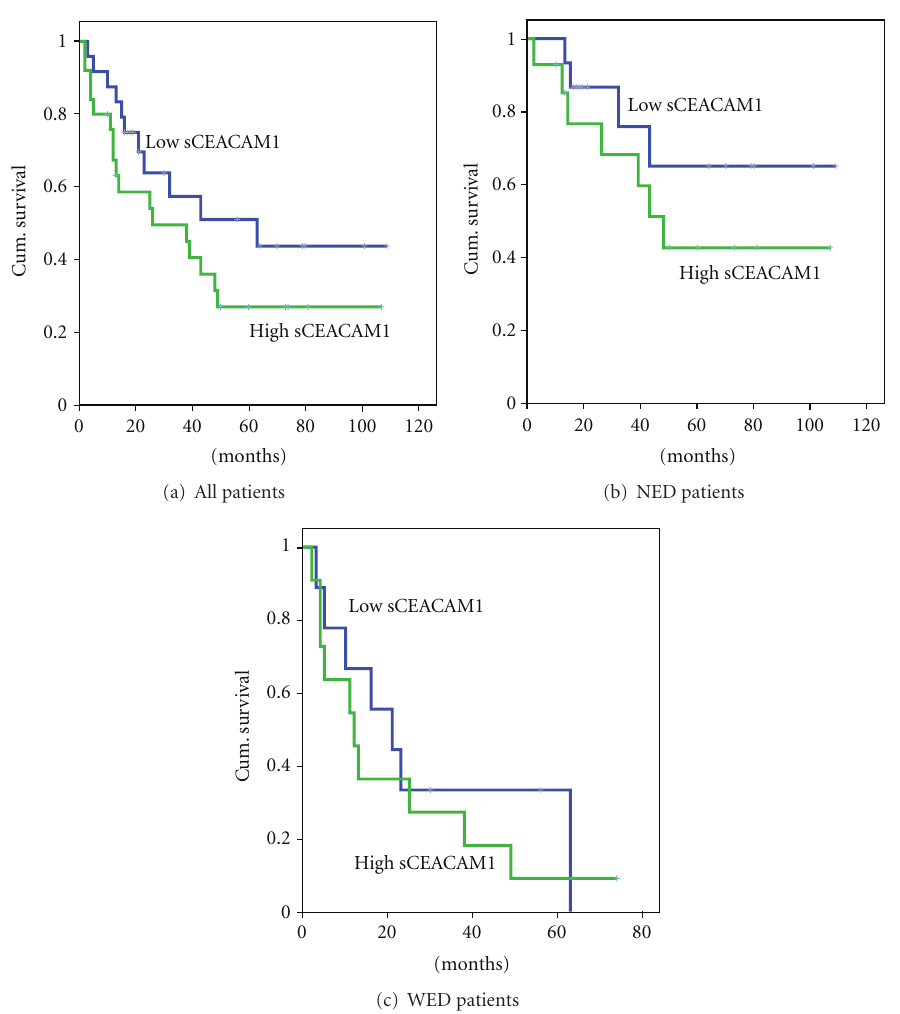
Figure 2: The correlations between sCEACAM1 and survival. The whole group of patients and NED exclusively or WED exclusively were divided into two groups (“low”/“high”) according to pre-treatment sCEACAM1 median level, and the survival rate of each subgroup was analyzed by Kaplan-Meier analysis. Group sizes were as follows: N = 24 (low) and N = 25 (high) in (a); N = 15 (low) and N = 14 (high) in